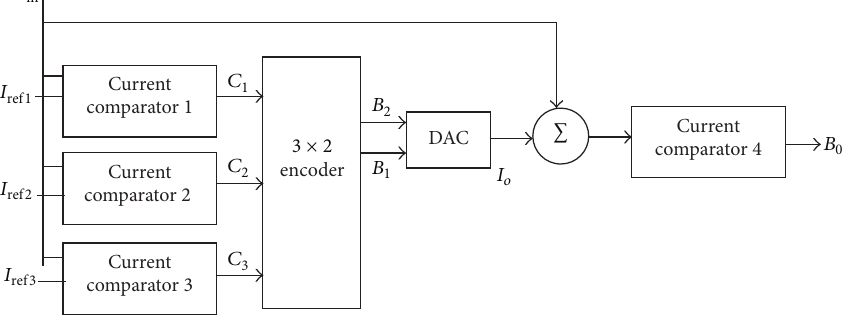
Figure 12: Two-step 3-bit CM flash ADC